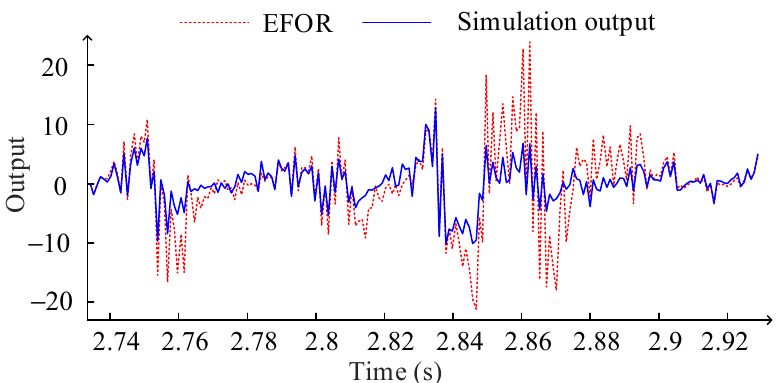
Figure 2. Comparison between the EFOR output and the simulation output by MPO.